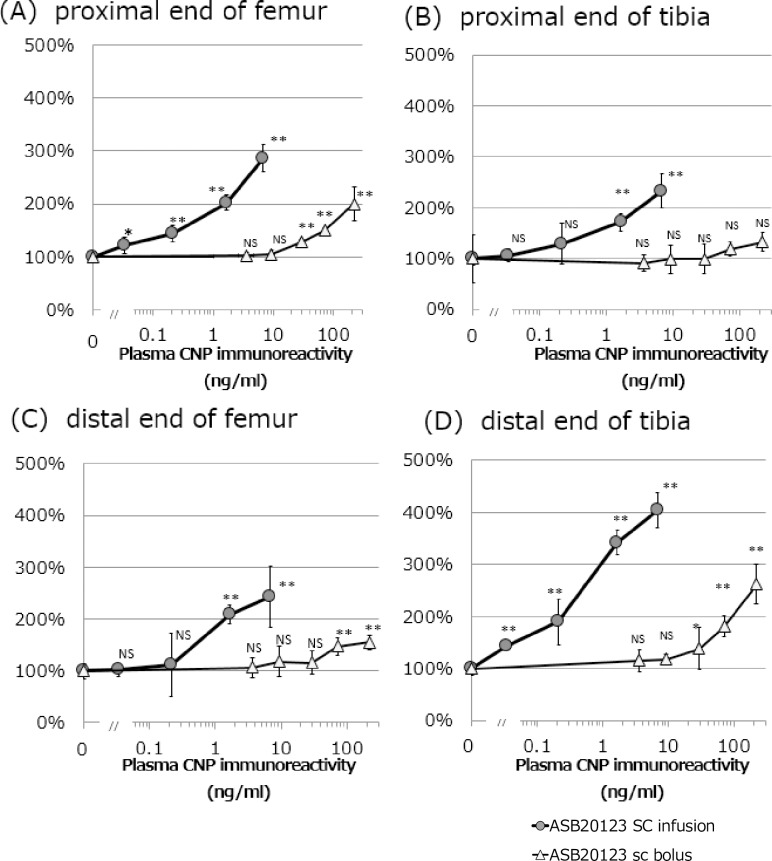
Correlation between plasma CNP immunoreactivity and growth plate thickness of lower limbs [proximal ends of femur (A) and tibia (B), and distal ends of femur (C) and tibia (D)] in rats after sc bolus injections or infusion of ASB20123 at 0, 0.005, 0.015, 0.05, 0.15, and 0.5 mg/kg/day for 7 days. Each value represents the mean ± SD of 4 or 5 rats. The horizontal axis indicates the mean plasma CNP immunoreactivity concentration at 15 min after the 1st dose for the sc bolus injection groups or mean plasma CNP immunoreactivity on the 2nd day for the sc infusion groups. The vertical axis indicates the mean percentage of growth plate thickness compared to the respective control groups. Plasma CNP immunoreactivity after sc infusion of ASB20123 at 0.005 mg/kg/day was not detected. NS: not significant (p > 0.05), *: p < 0.05, **: p < 0.01 compared to the control group (0 mg/kg/day) using Dunnett’s test (logarithm conversion).